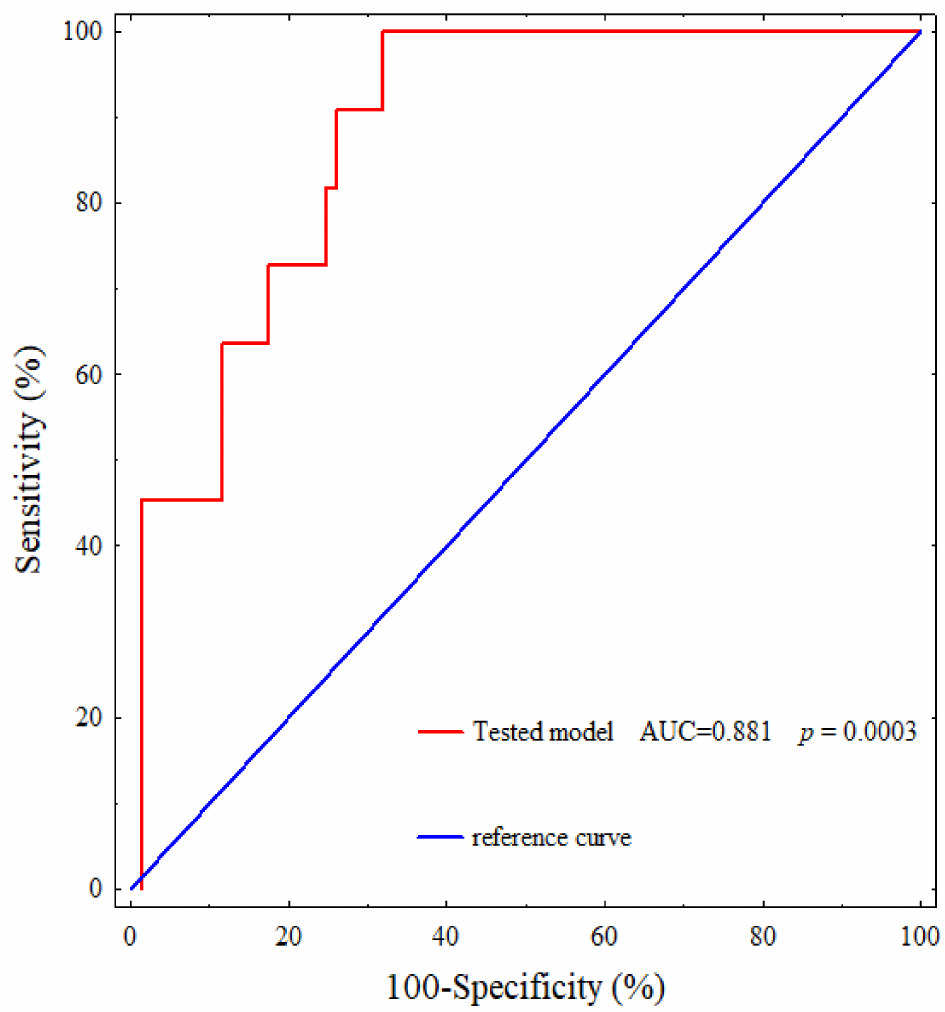
Figure 2. Receiver operating characteristic (ROC) curve for the tested model in predicting disease-free survival in IBrC